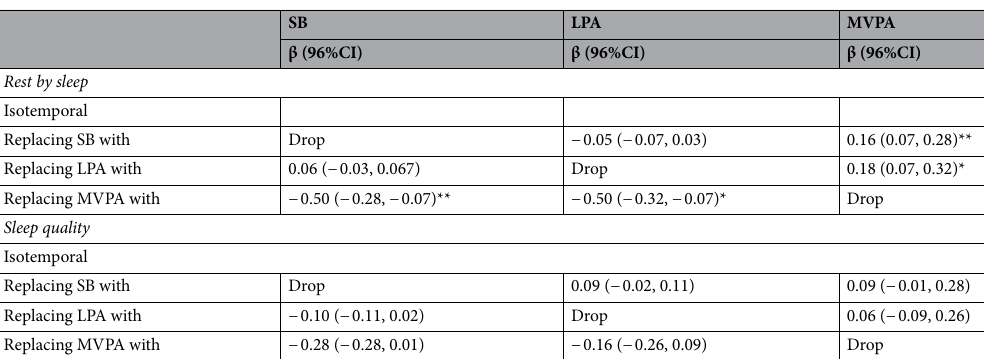
Table 3. Isotemporal models examining the associations of SB, LPA, and MVPA with sleep measures in women (n = 417). Regression coefficients correspond to a 60 min/day increment of each activity. All models were adjusted for age, education, marital status, body mass index, living status, income, working status, and smoking. The single-activity and isotemporal models were also adjusted for the accelerometer daily wear time. SB sedentary behaviour, LPA light-intensity physical activity, MVPA moderate-to-vigorous physical activity. * p < 0.05; ** p < 0.001.